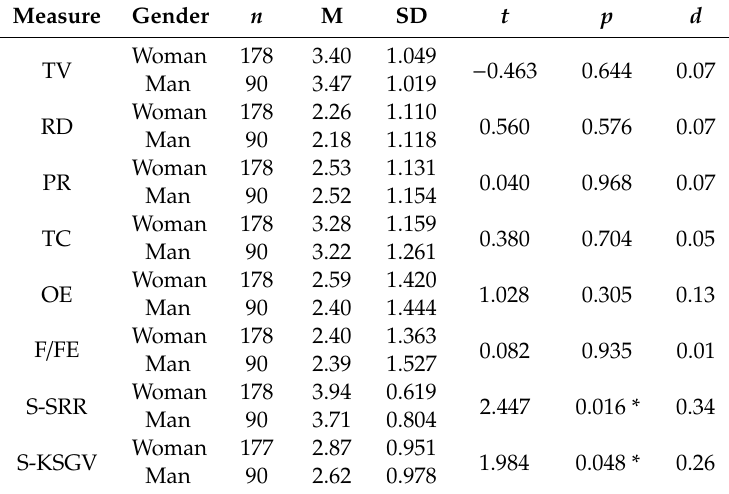
Table 5. Significant di ff erences in knowledge of situations of violence, sources of information and other situations according to